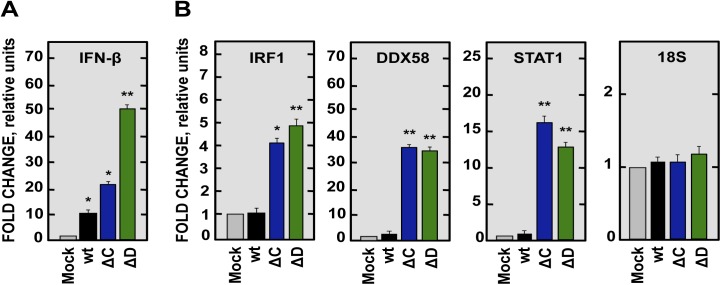
Expression of IFN-β and ISGs in SARS-CoV-nsp1* attenuated mutants infected cells.DBT-mACE2 cells were mock-infected or infected at a moi of 0.125 with SARS-CoV-nsp1* attenuated mutants or SARS-CoV (wt). Cellular RNAs were extracted at 48 hpi and the expression of the indicated genes was determined by RT-qPCR. In each case, the corresponding mRNA expression levels were plotted as fold change relative to expression levels in uninfected cells. (A) IFN-β. (B) ISGs such as IRF1, DDX58 and STAT1, and 18S rRNA as a control. Error bars represent standard deviations of the means from three experiments. Statistically significant data compared to uninfected cells are indicated with one (P < 0.05) or two (P < 0.01) asterisks.